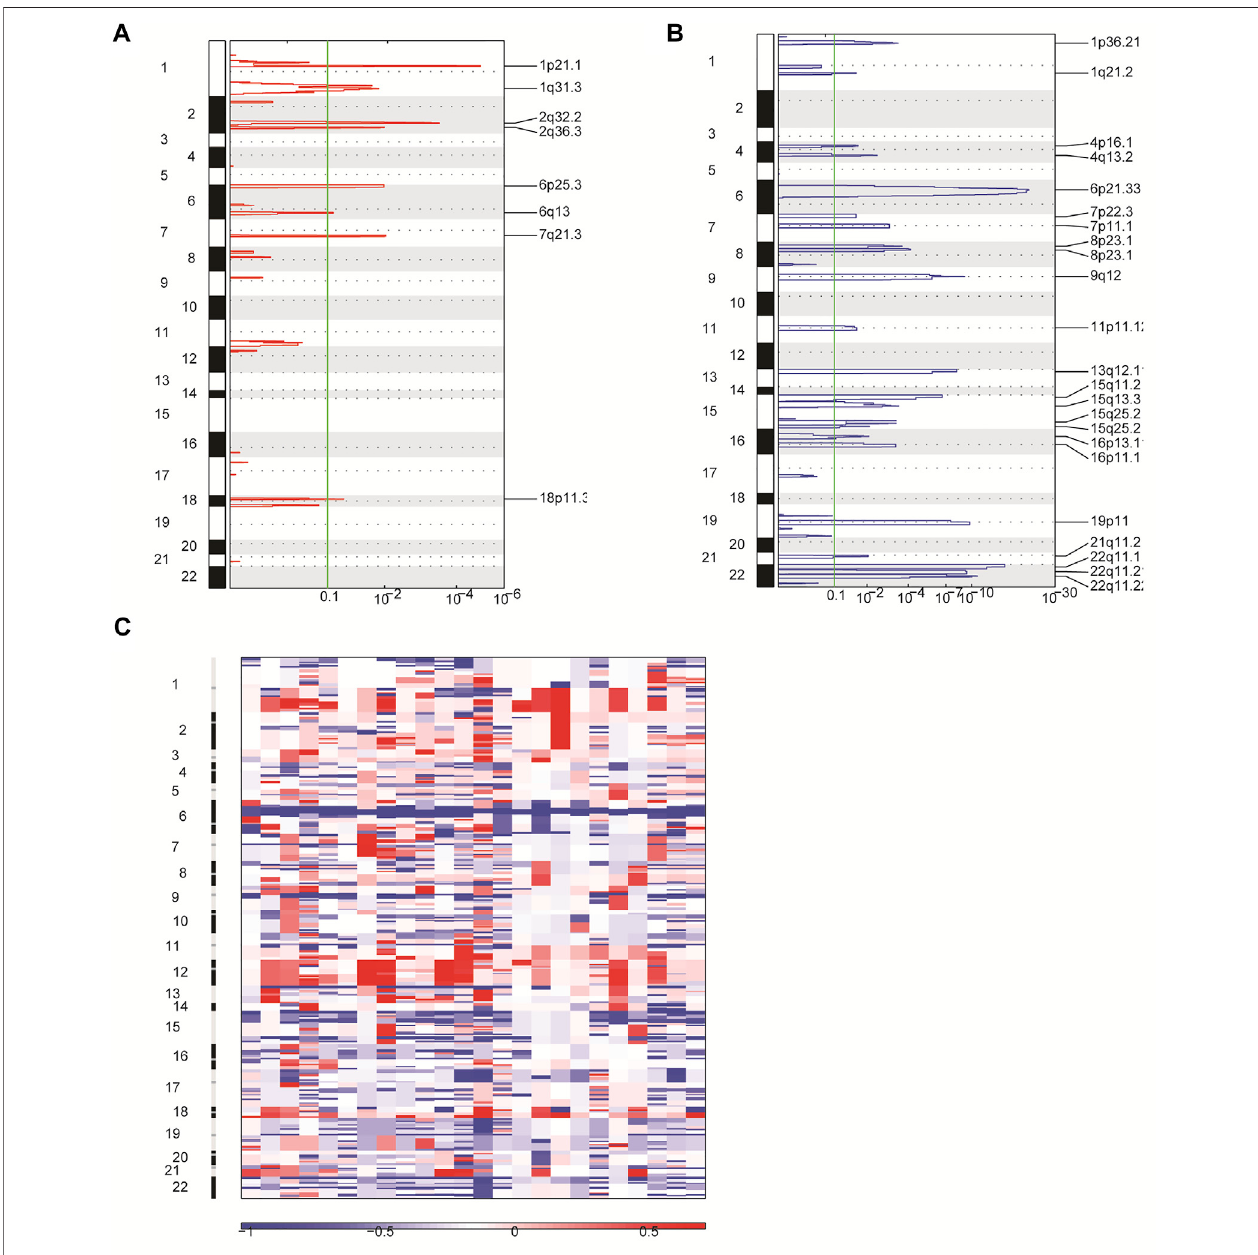
FIGURE 4 | Overview of CNVs in 24 patients with primary CNS DLBCL using WGS. (A,B) CNVs were analyzed by GISTIC. Chromosome positions are indicated alongtheyaxis.Onthex-axis,focalampli fi cations (A) ordeletions (B) aremarkedwithhorizontalblueorredbars,respectively.Thegreenlinerepresentsthesigni fi cance threshold of q < 0.1 (the false discovery rate after multiple hypothesis testing). (C) Heat map images of the 24 patients with primary CNS DLBCL. In each heat map, the samples are arranged from left to right, and the chromosome arrangement fl ows vertical, top to bottom ordering. Red represents CN gain and blue represents CN